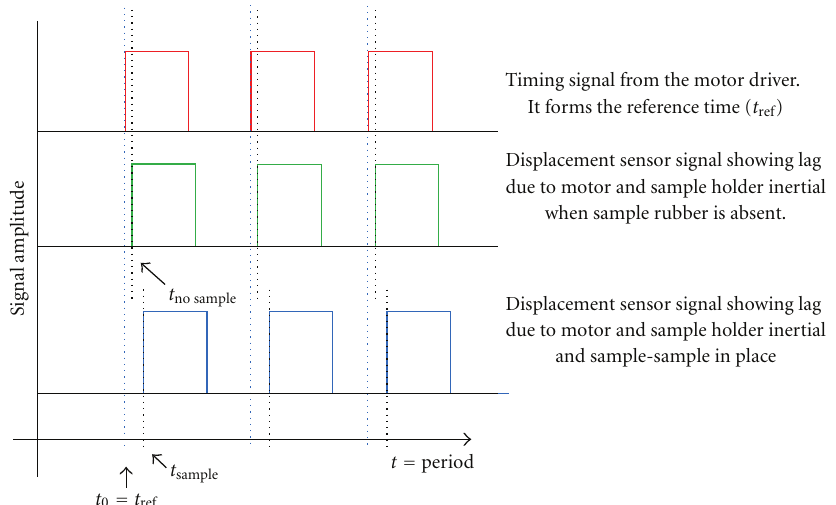
Figure 23: Closer view of the test board.